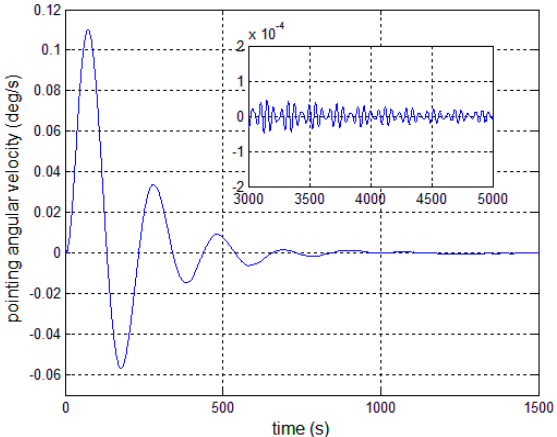
Figure 12. Antenna pitch angular velocity error—controller, Equation (30).